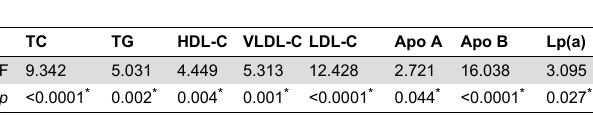
The results were adjusted for gender, age and the history of hypertension, diabetes mellitus ,coronary artery disease using univariate general linear model. *. p< 0.05; PD: TC: total cholesterol; TG: triglyceride; VLDL-C: very low density lipoprotein cholesterol; HDL-C: high density lipoprotein cholesterol; LDL-C: low density lipoprotein cholesterol; apo A: Apolipoprotein A; Apo B: apolipoprotein B; LP(a): lipoprotein a;F: univariate general linear model value.